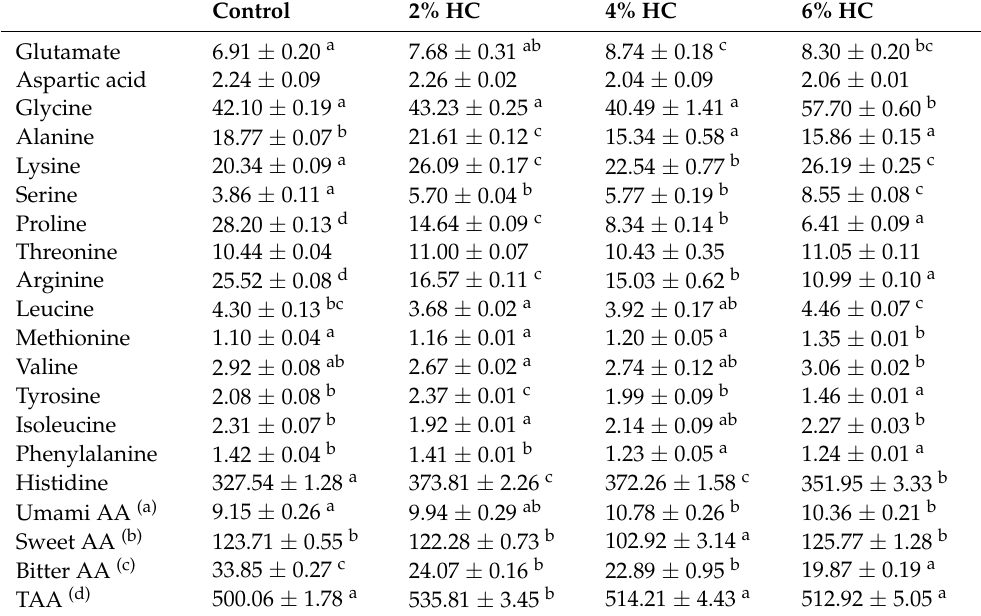
Table 8. Effects of hydrolyzed collagen replacing fish meal on muscle free amino acid of triploid crucian carp (mg/100 g, wet